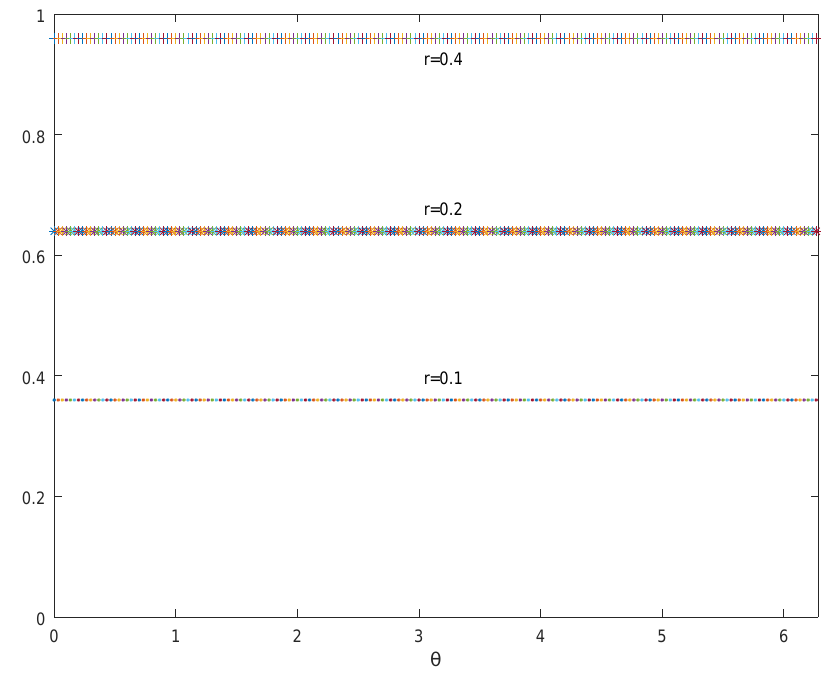
Figure 3. The relations between the phase term and type-A entropy measure of e 2